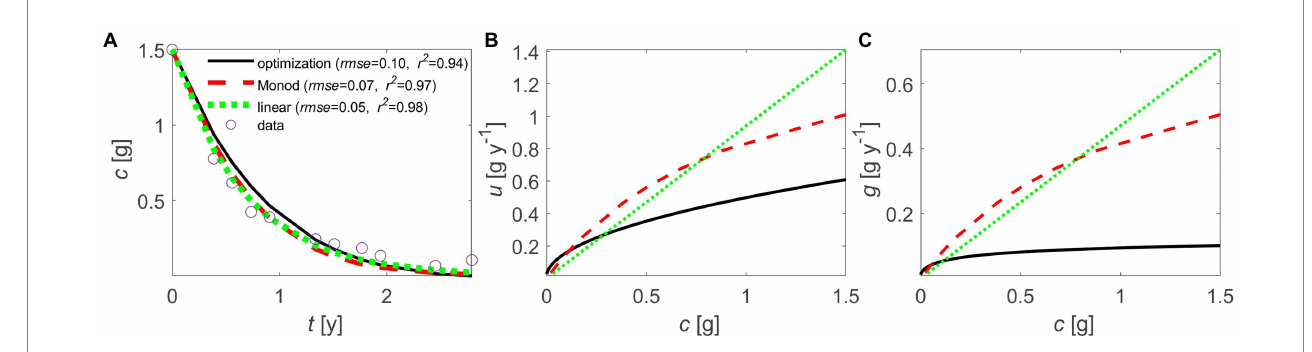
FIGURE 7 vc = u Comparison of linear ( u kc = ), Monod-type ( + ), and optimal decomposition kinetics to describe litter C mass loss: (A) temporal trajectory of litter C K c ( c ) and model fitting performance (RMSE: root mean square error; R 2 : coefficient of determination), (B) decomposition rate as a function of litter C ( u ( c )), and (C) microbial growth rate as a function of litter C ( g ( c )). Data are from Osono and Takeda (2005); see details on model fitting in Section 2.8 (linear model parameter: k = 0.94 y − 1 ; Monod model parameters: v = 1.68 g y − 1 , K = 1.00 g; optimization model parameters: b= 0.3 g y − 1 , r= 0.002 g y − 1 ).